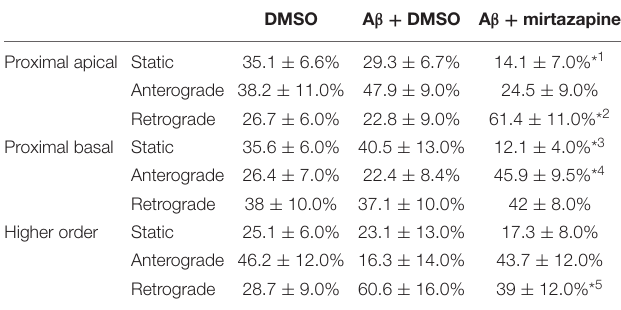
TABLE 3 | Summary of the pGOLT dynamics in high KCl-stimulated cultures. DMSO A β + DMSO A β + mirtazapine Proximal apical